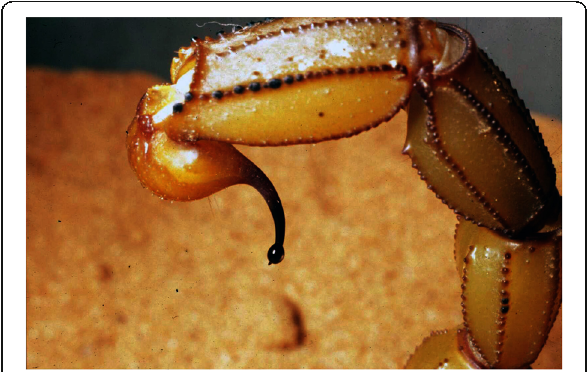
Fig. 5 Telson of an extant buthid, Buthus lienhardi Lourenço. An adult female from